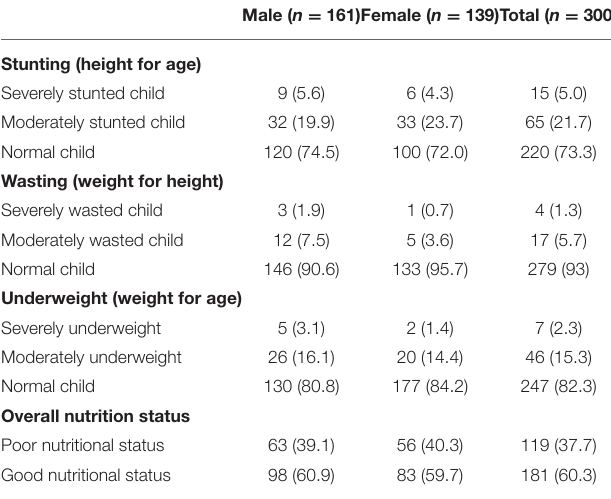
TABLE 3 | Nutritional status of children, n